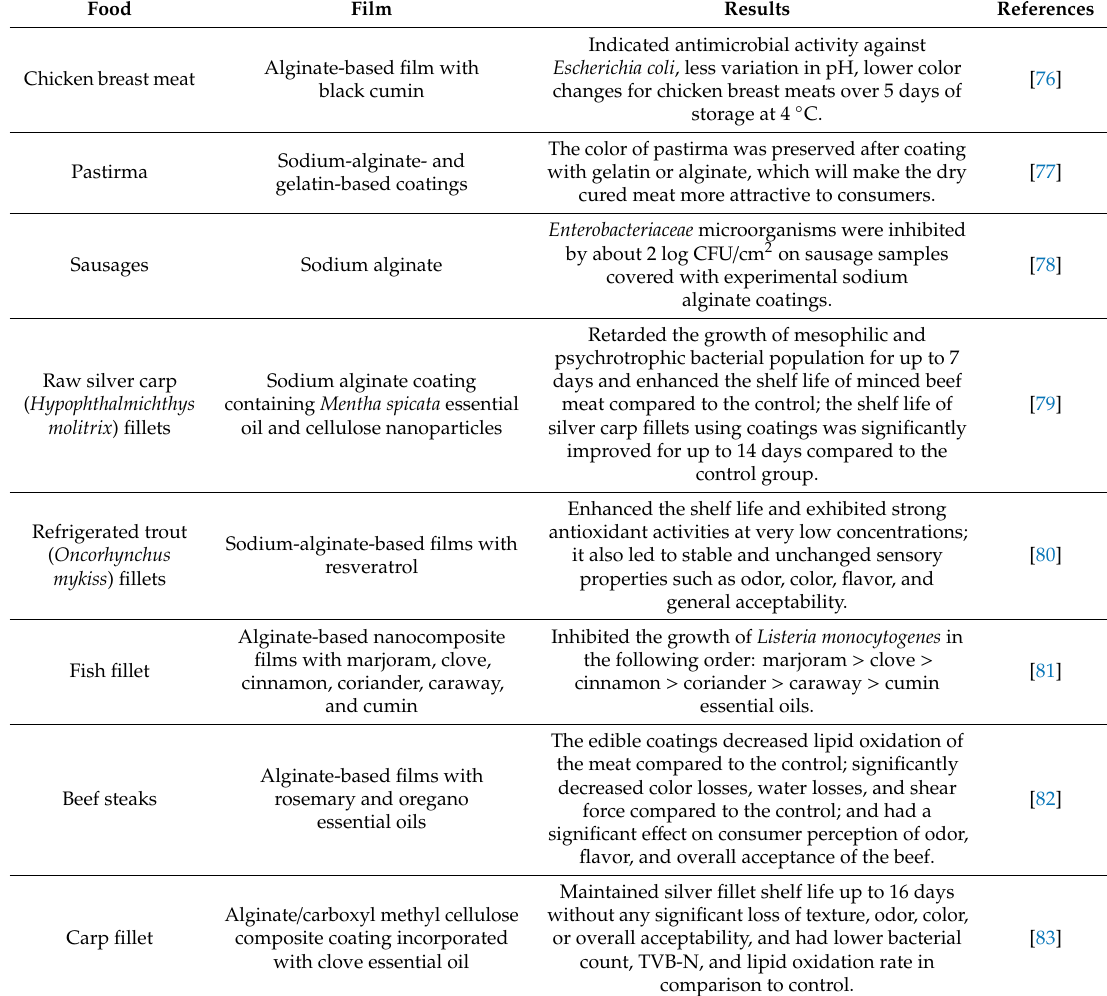
Table 3. Alginate-based films and coatings with applicability in the meat industry.